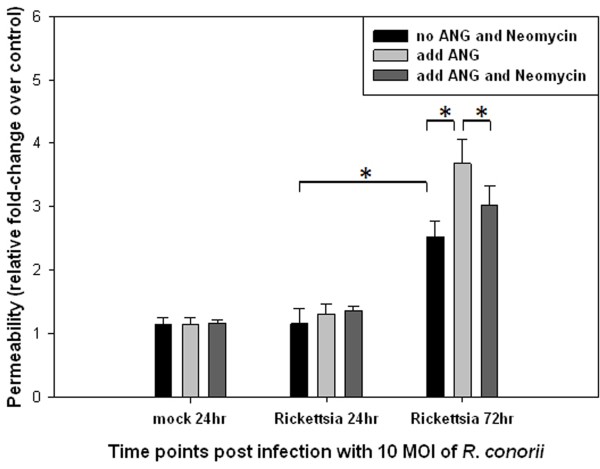
conorii infection-initiated cytoplasmic translocation of exogenous rANG and enhanced para-endothelial hyperpermeability at 72 hrs p.i., this effect can be attenuated by co-administration of neomycin with rANG. Endothelial cells were seeded on type I rat-tail collagen-coated polycarbonate transwell filters and infected with R. conorii at an MOI of 10 in triplicate, or mock infected. After 24 and 72 hr, HUVECs were exposed to ANG or co-administration of neomycin with ANG for two hrs. FITC-dextran was added to the upper chamber medium, and the presence of FITC dextran in the lower chamber was quantified after 1 hr. The results are expressed as the fold-increase in monolayer permeability over basal permeability levels (* P< 0.05). Experiments were performed in replicates of four.